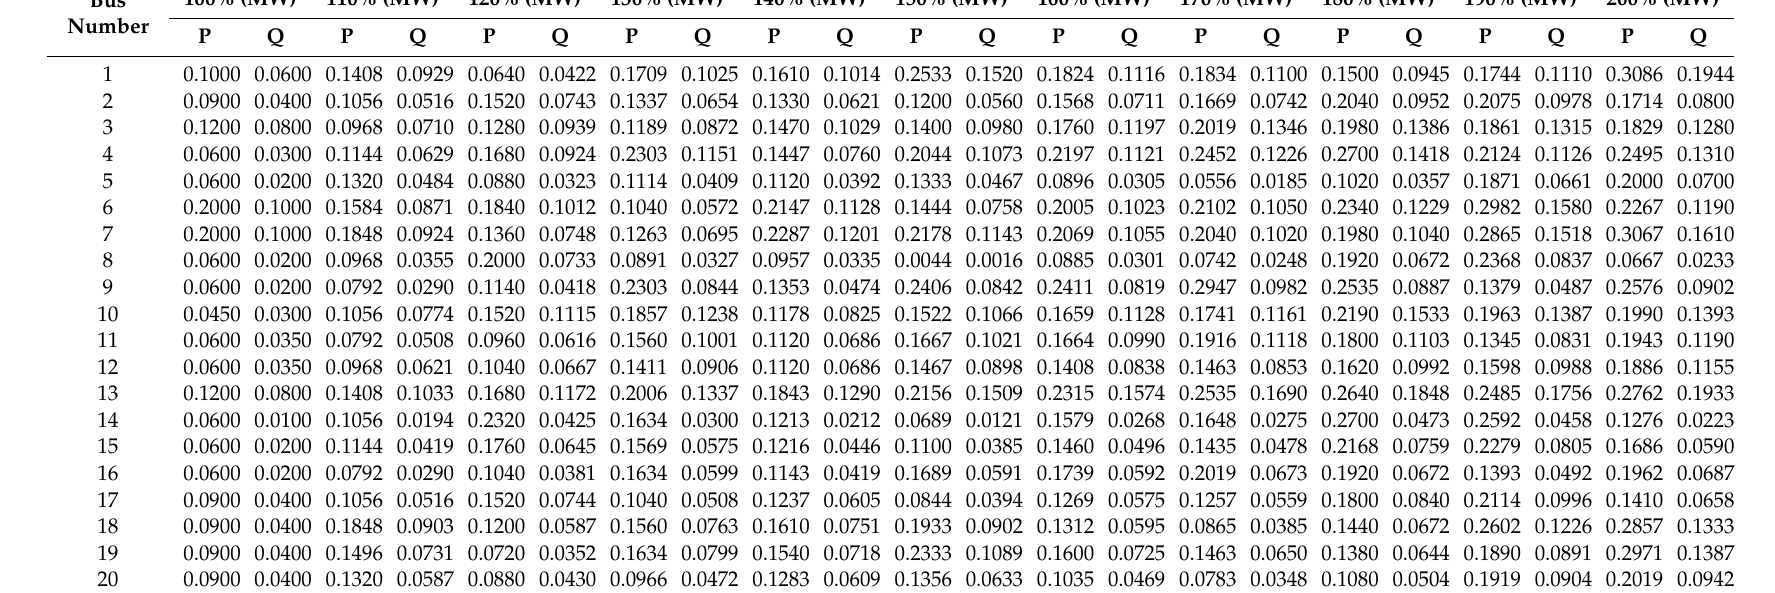
Table 10. The changing power demands of all buses from 100% to